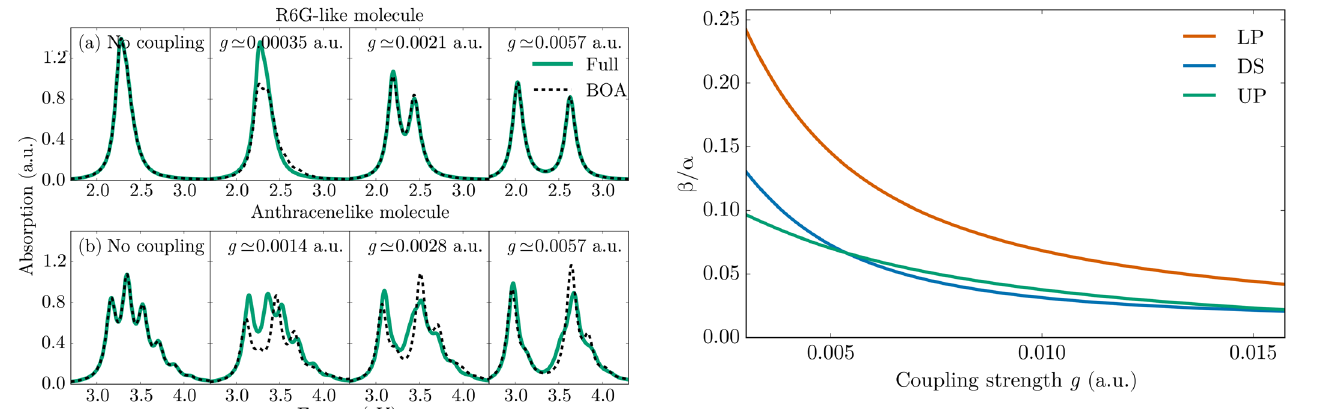
FIG. 7. Coupling between nuclear motion in different mole- cules for the lower (LP) and upper polariton (UP) and dark-state FIG. 6. Absorption cross section of two molecules driven (DS) PES. Results are shown as the ratio β = α between the coherently, calculated using the full Hamiltonian without prefactors of the off-diagonal R 1 R 2 and diagonal R 2 approximation (solid green lines) and within the BOA (dashed Eq. (11), for the R6G-like model black lines). Results are shown for the (a) R6G-like and (b) anthracenelike model molecules, for several values of the ffiffiffi p 2 coupling strength g . The values of g are scaled by 1 = with respect to the single-molecule case (Fig. 4) in order to obtain the same total Rabi frequency Ω . R